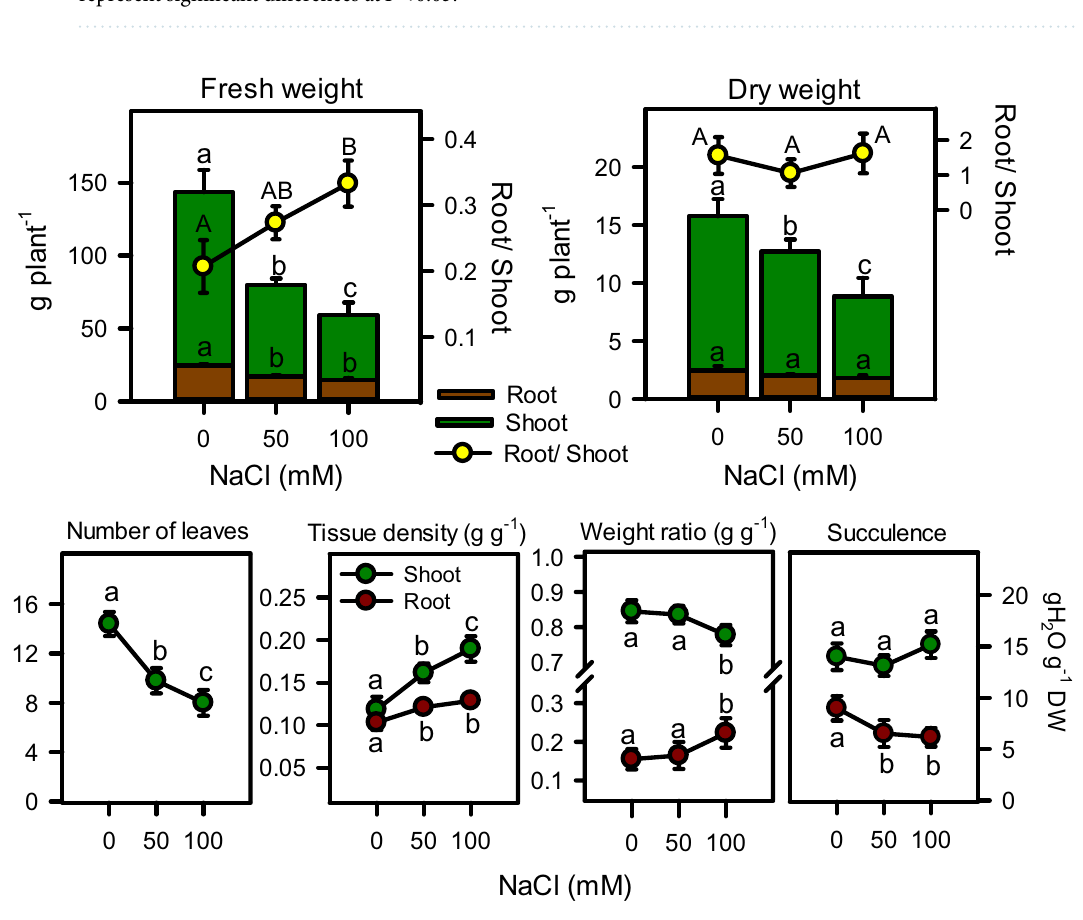
Figure 2. Fresh and dry biomass (shoot, root, and total plant), root/shoot, number of leaves, tissue density, weight ratios, and succulence of Moringa oleifera under different salinity treatments. Different letters indicate significant differences at P <